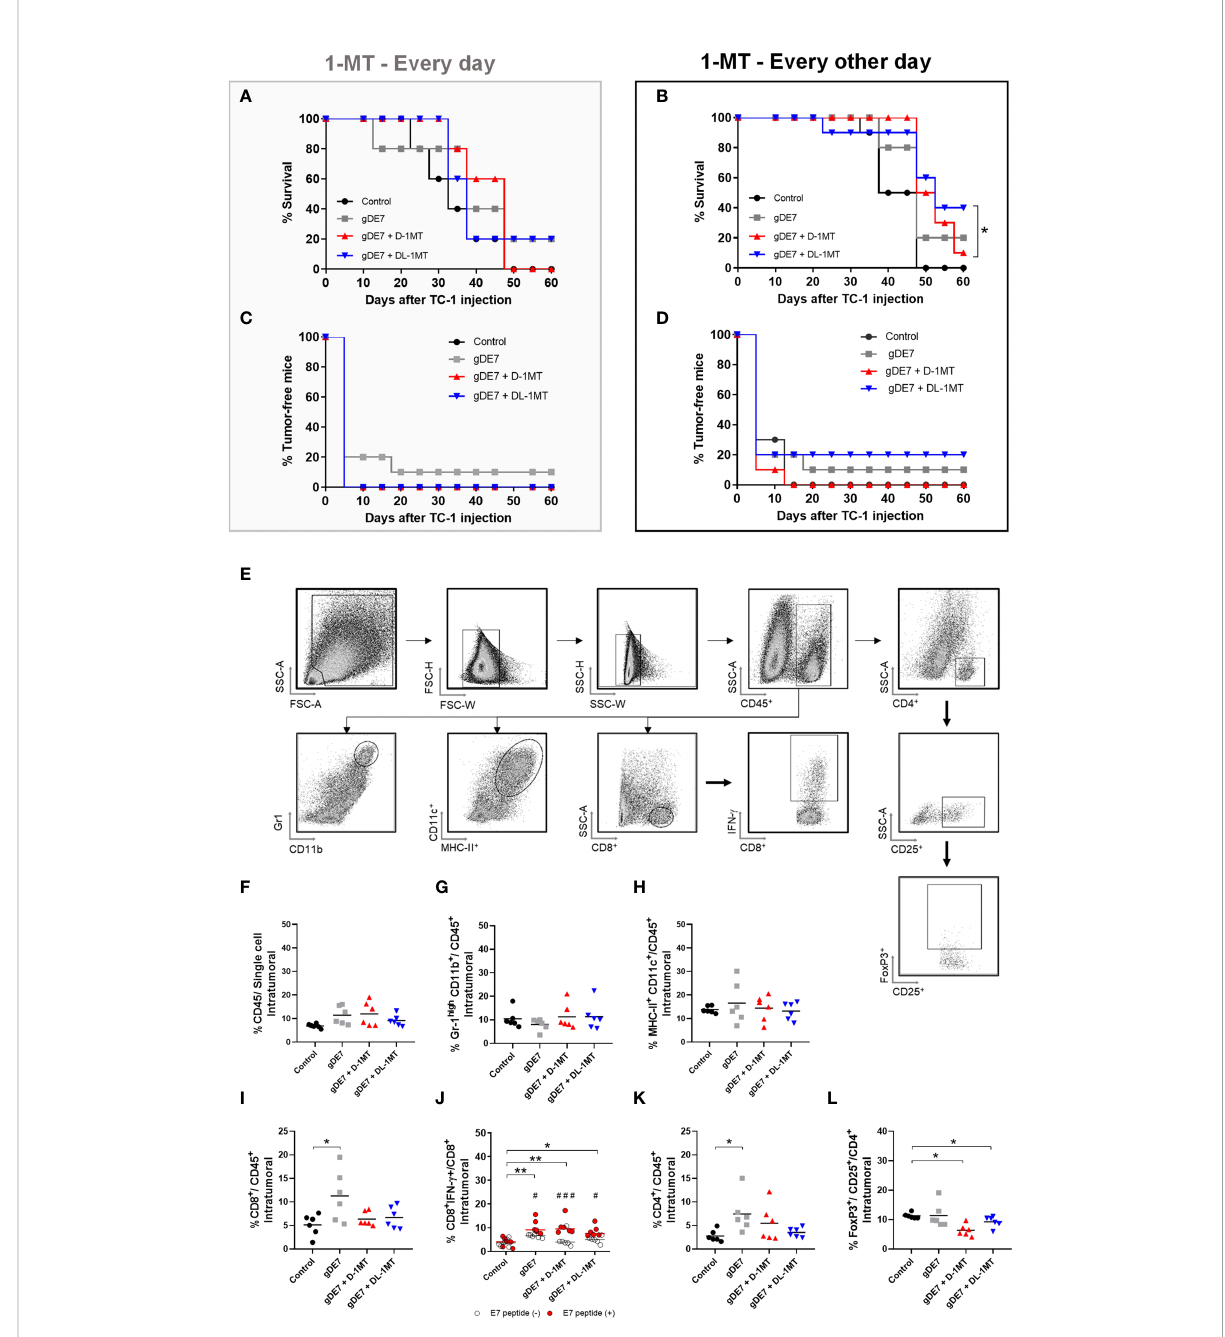
FIGURE 2 The combination of gDE7 and 1MT improves mice survival depending on their administration regimen. (A – D) The data represent the average of two independent experiments (n=5, total n=10). (A, B) Survival curves. Data were analyzed by Kaplan-Meyer test. (A) Two mice from gDE7 group and from gDE7 + DL-1MT survived until day 60. (B) Two, one, and four mice from gDE7, gDE7 + D-1MT, and gDE7 + DL-1MT groups survived until day 60, respectively. (C, D) Tumor-free mouse curves. Data were analyzed by ANOVA test* p <0.05. (E) Gating strategy for immune cell analyses in the tumor microenvironment, evaluated at day 21 after the tumor engraftment. Doublets were initially excluded by FSC-H versus FSC-W parameters, followed by SSC-H versus SSC-W parameters. Cells were gated by the expression of CD45 + and successively analyzed for: CD8 + , followed by CD8 + IFN-g + ; CD4 + , followed by CD25 + and FoxP3 + CD25 + (T regulatory cells); CD11c high MCH-II high (dendritic cells); and Gr1 high CD11b + . (F) Frequency of CD45 + cells. (G) Frequency of Gr1 high CD11b + cells. (H) Frequency of CD11c high MCH-II high cells. (I) Frequency of CD8 + T cells. (J) Frequency of E7-speci fi c CD8 + IFN-g + /CD8 + cells. (#) p<0.05 represent the statistical signi fi cance of stimulated (red dots) versus non-stimulated (white dots) cells inside each experimental group. (K) Frequency of CD4 + T cells. (L) Frequency of FoxP3 + CD25 + CD4 + cells. Data representative of two independently performed experiments (n=6). Statistical signi fi cance: (*) p<0.05, (**) p<0.01 by ANOVA. (#) p<0.05 (###) p<0.001 represents the ANOVA statistical signi fi cance of stimulated (red dots) versus non-stimulated (white dots) cells inside each experimental